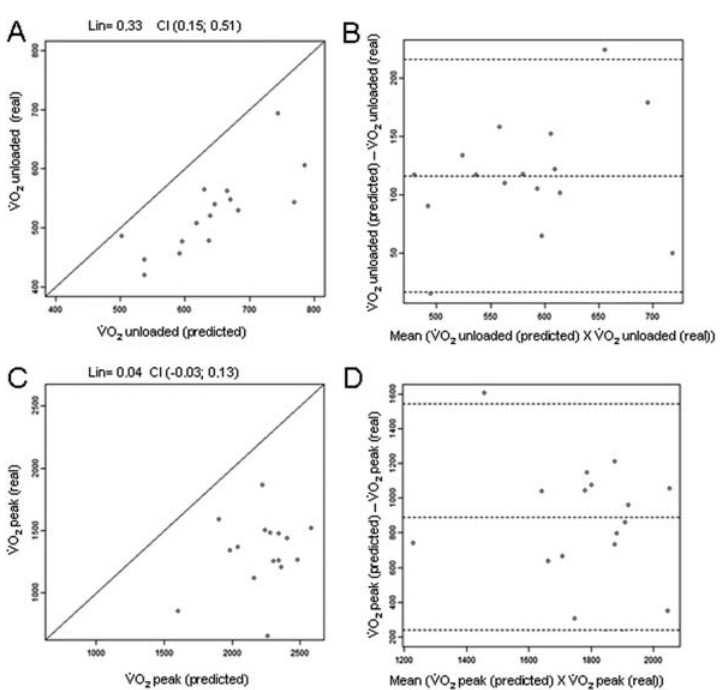
: O 2unloaded ð real Þ ð A Þ and : O 2unloaded ð predicted Þ vs : O 2peak ð predicted Þ vs